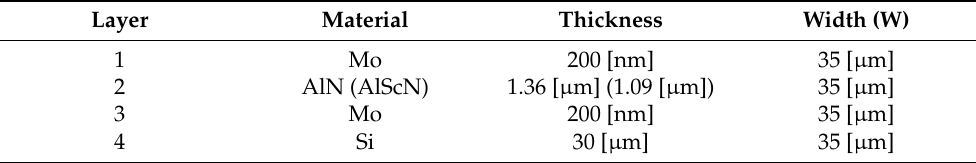
Figure 7. ( a ) SEM image of the cantilever beam; ( b ) the test and simulation results for AlN and AlScN cantilever beams with different lengths of AlN and AlScN; ( c ) the test results of the AlN and AlScN cantilevers. Table 4. The material and thickness of each layer used in the calculation of the cantilever. Layer